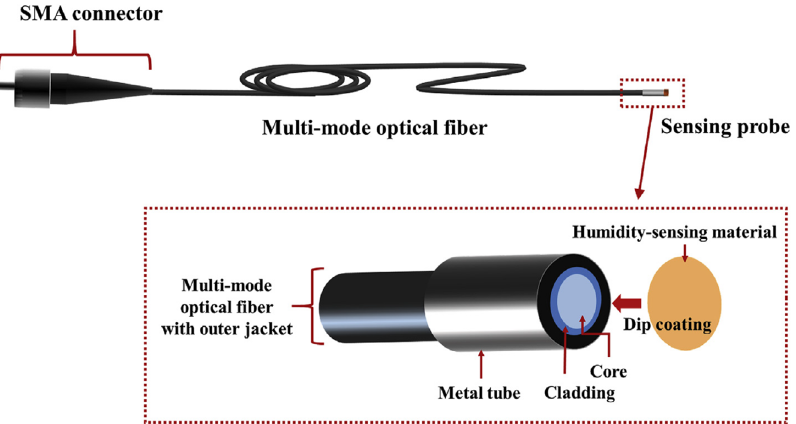
Figure 33. Point sensor. Humidity-sensing probe and the internal structure of the sensor head. Reprinted with permission from ref. [176]. Copyright 2020 Elsevier